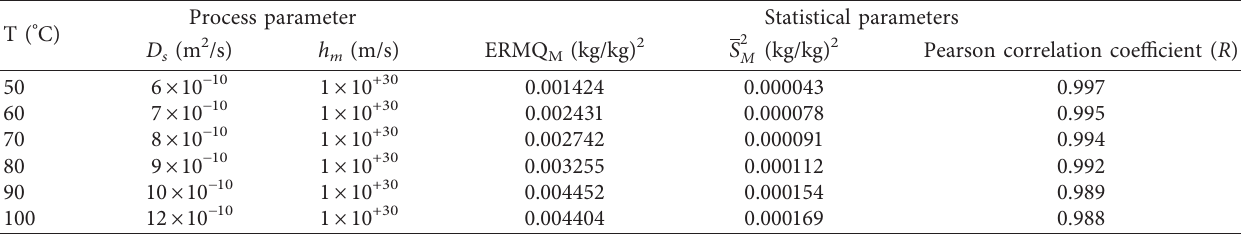
Table 7: Values of mass transport coefficients estimated numerically.